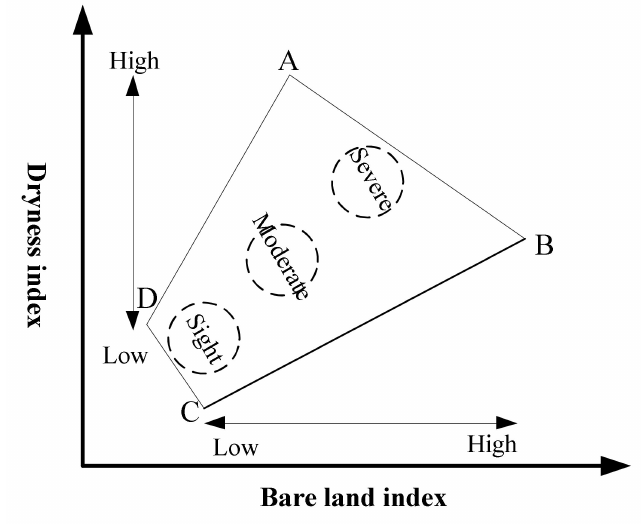
Figure 3. Principle of the feature space